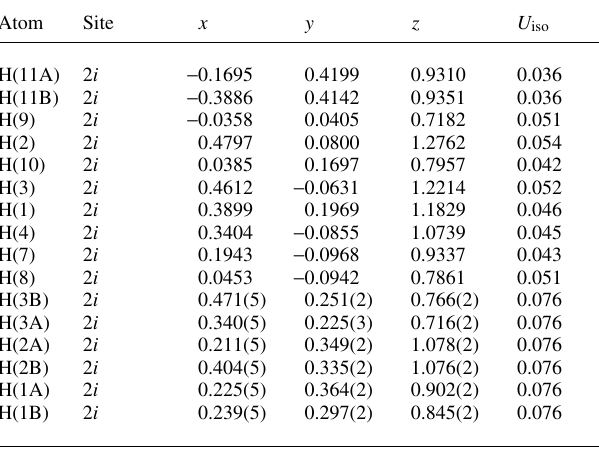
Table 2. Atomic coordinates and displacement parameters (in Å 2 )